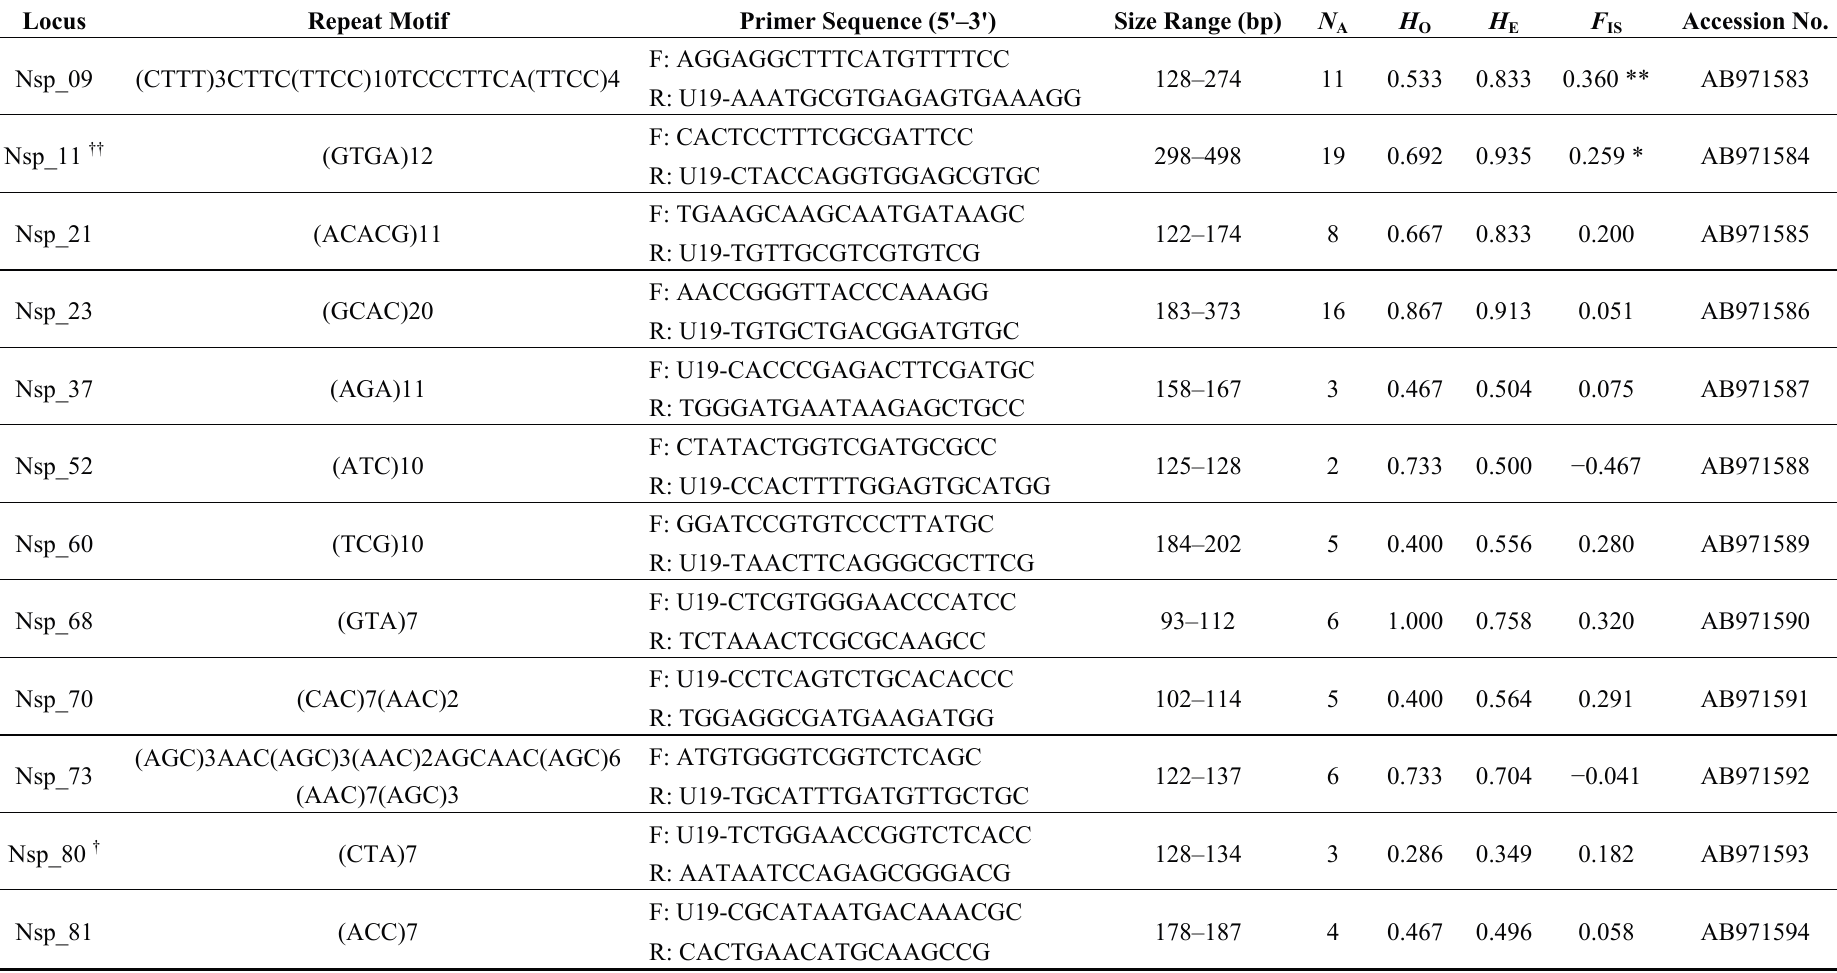
Table 1. Characteristics of the 12 developed polymorphic microsatellite loci in 15 individuals of Neoverruca sp. Columns show the locus name, the primer sequence, the repeat motif, the size range of amplification products, including the U19 sequence, numbers of alleles ( N ( H ) and expected ( H ) heterozygosities, and the index of deviation from Hardy-Weinberg equilibrium ( F O E